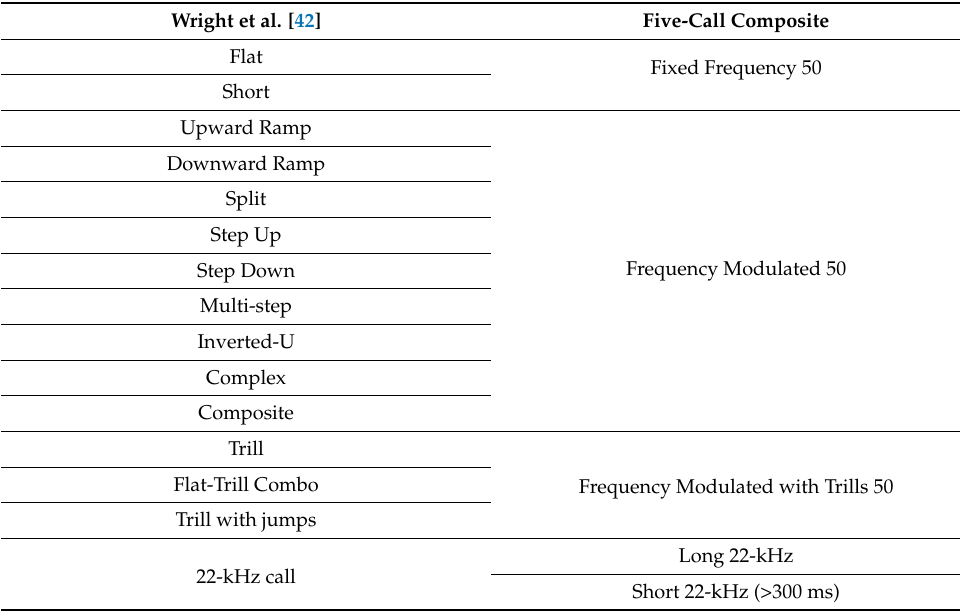
Table 2. Call types in the Wright et al. [42] classification scheme and their mapping to the five-call composite with representative spectrograms from